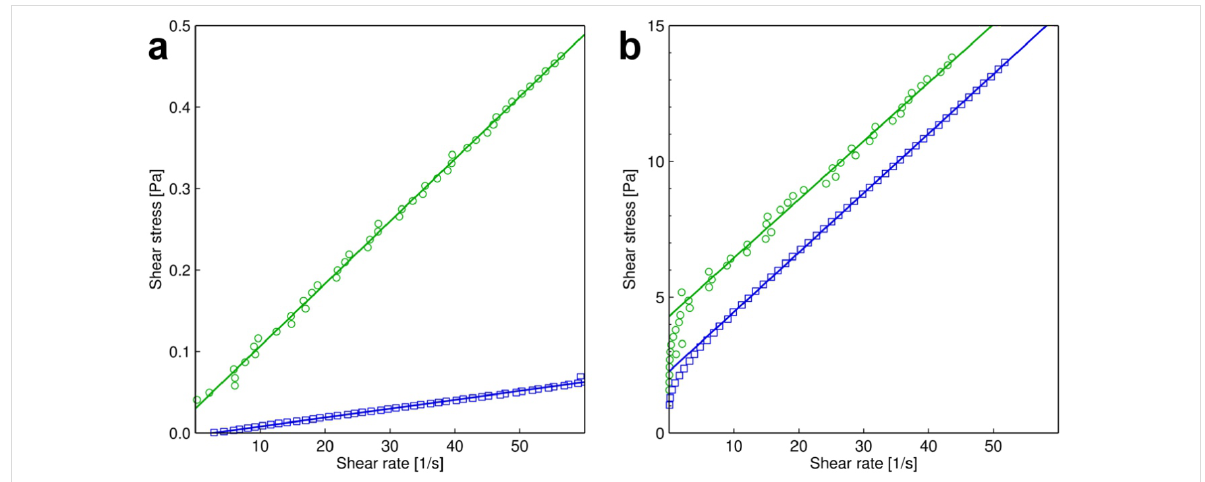
Figure 2: Rheological characterization of selected emulsions obtained by using plate-plate rheology within a shear rate range up to 60 s − 1 . (a) Green circles: emulsion SG2, blue squares: emulsion SA2, both measured at 40 °C. (b) Green circles: emulsion SG4, blue squares: emulsion SA4, both measured at 25 °C.